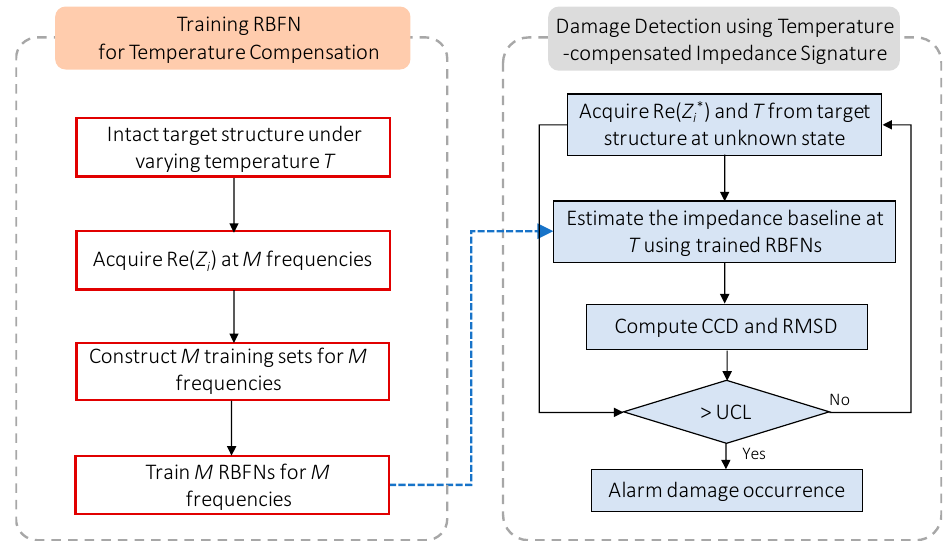
Figure 9. RBFN-based temperature compensation algorithm for impedance-based damage detection [29] .